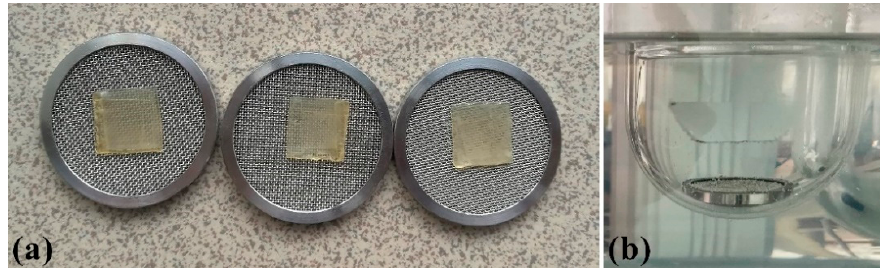
Figure 3. ( a ) Samples on metal mesh disc; ( b ) set up for dissolution test.